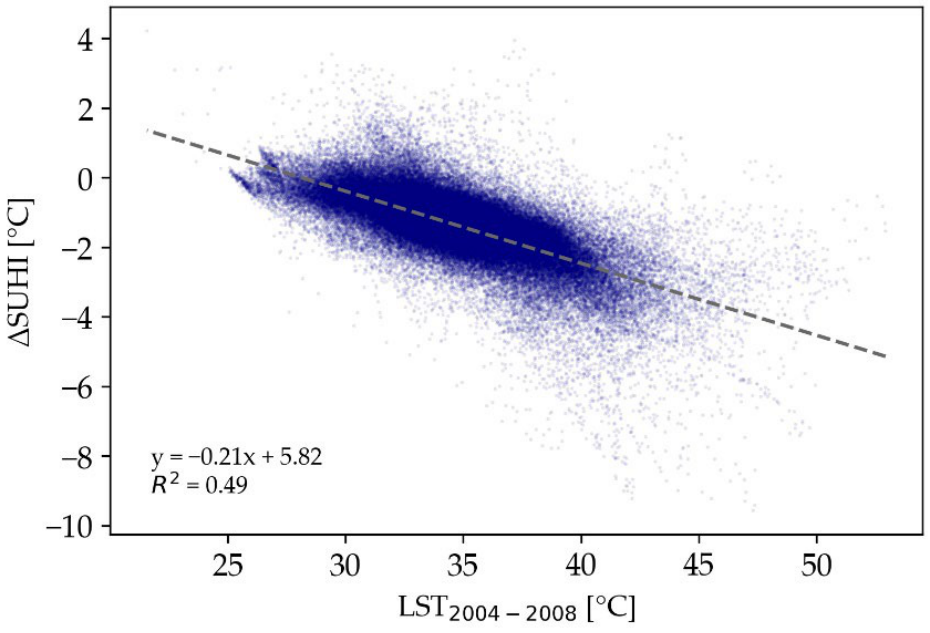
Figure 3. As in Figure 2, but for the correlation between the 2004–2008 average of land surface temperature (LST) and the change in surface urban heat island (ΔSUHI).